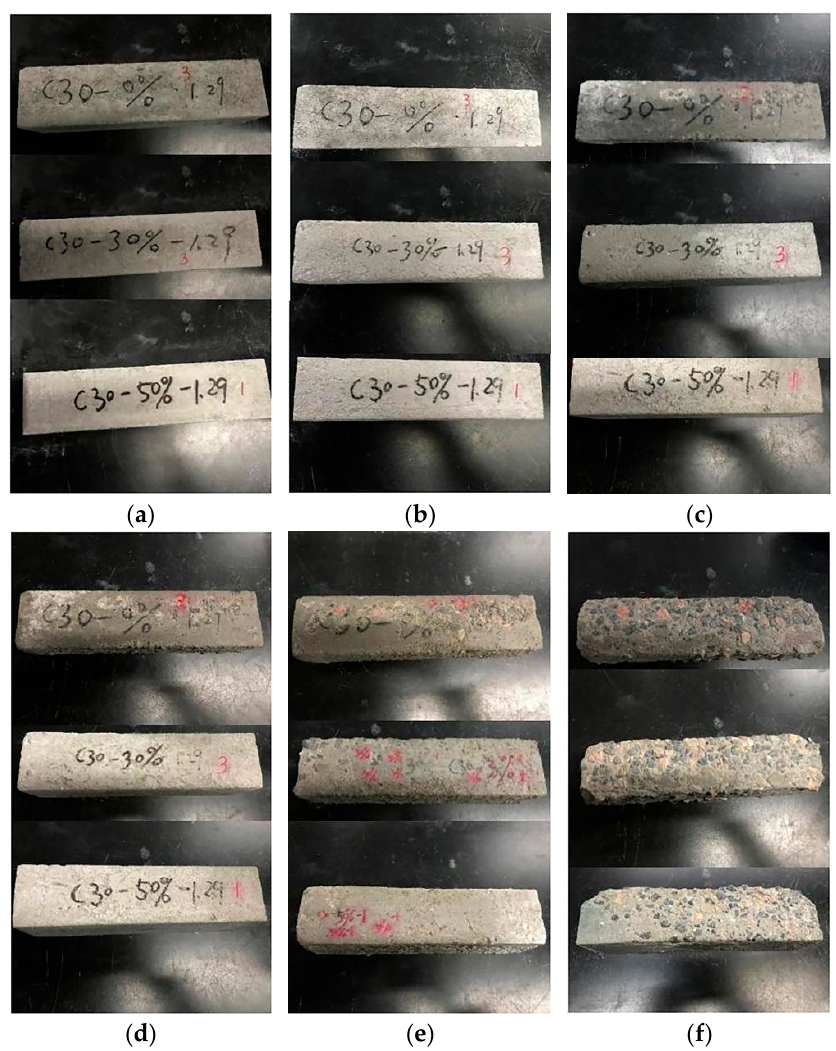
Figure 4. Damage shapes of different freeze–thaw cycles of C30 concretes. ( a ) 0 cycle, ( b ) 50 cycles,